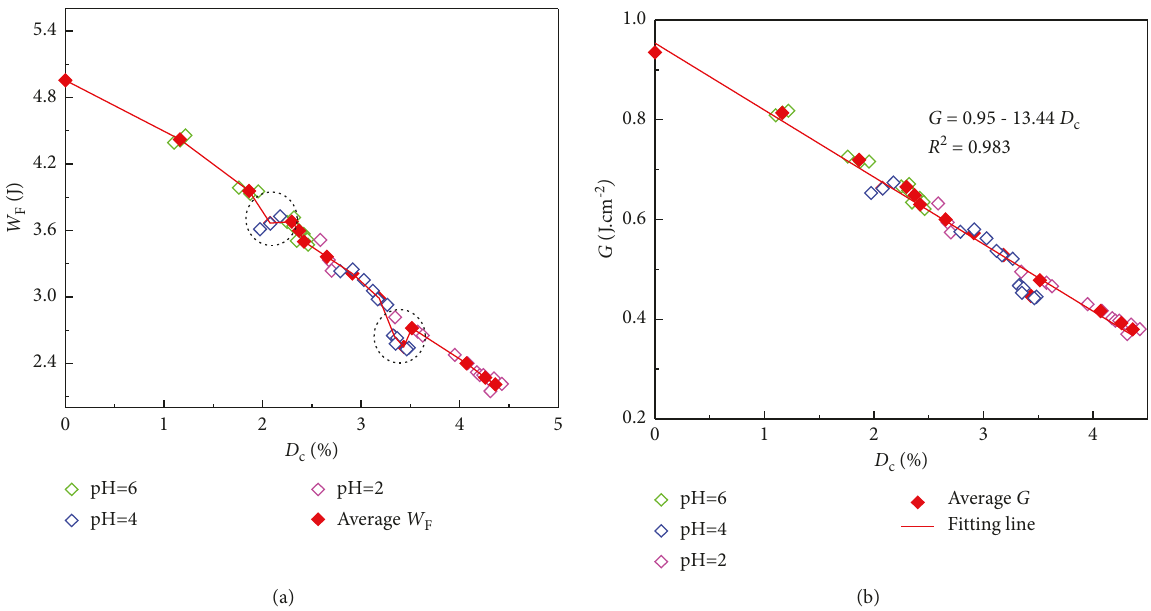
Figure 13: Variations in energy versus damage variable: (a) fracture energy, (b) fracture energy per unit fracture